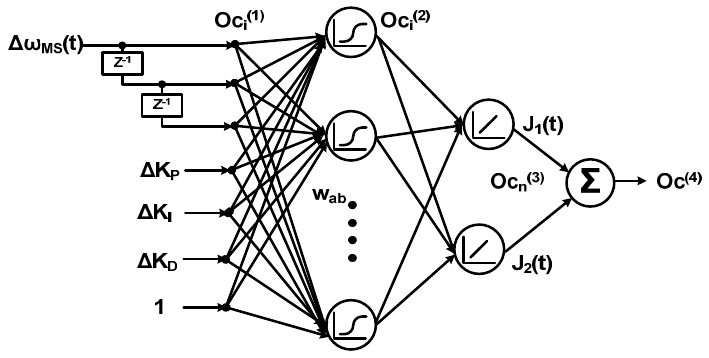
Figure 6. Critic network structure.